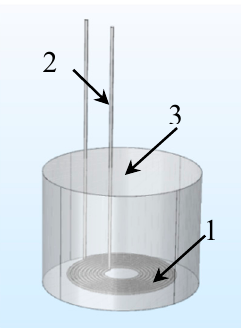
Figure 3. Design sketch of sensor, wherein 1 is leading line, 2 is sealing package, 3 is platinum coil.